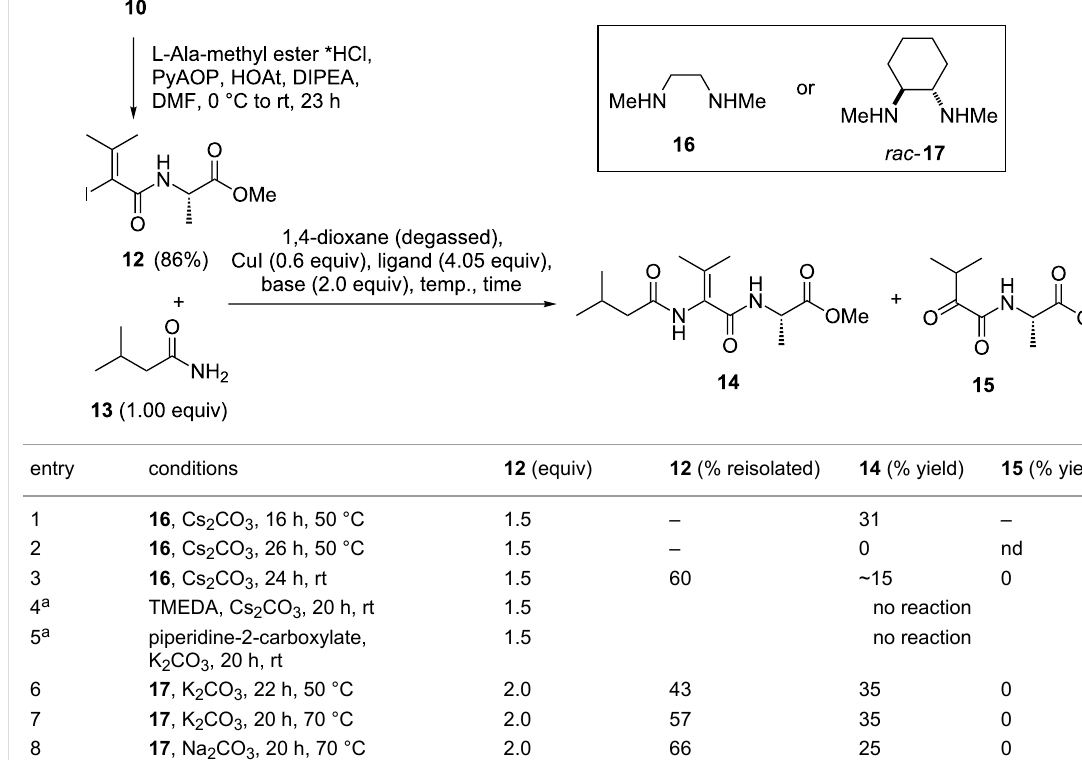
Table 1: Formation of amide 12 and optimization of C–N cross coupling reaction.